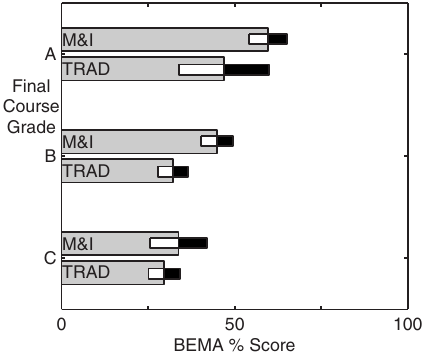
FIG. 8. The average post-test BEMA score of all students re- ceiving a particular letter grade in introductory E&M at NCSU is shown. The error bounds indicate 95% confidence intervals on the estimates of the average for each grade. The numbers of students for which grades were obtained are N =48 for traditional students and N =79 for